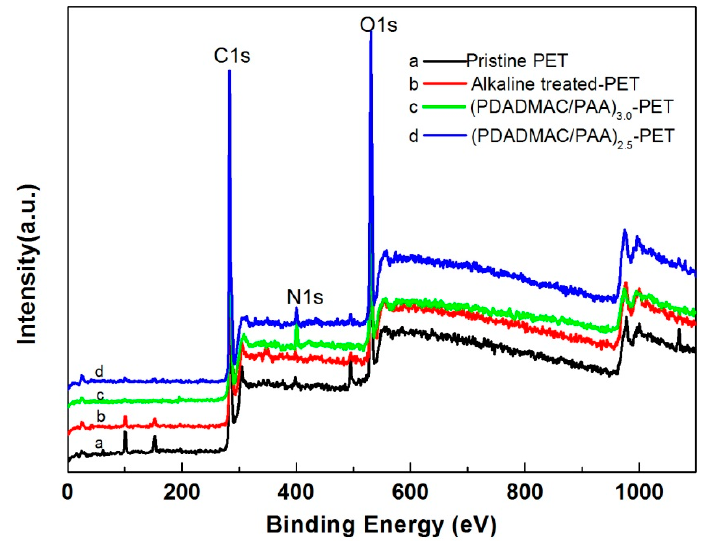
Figure 5. X-ray photoelectron spectroscopy (XPS) spectra of pristine fabric (a), alkaline treated fabric (b), (PDADMAC/PAA) 3.0 -PET fabric (c) and (PDADMAC/PAA) 2.5 -PET fabric (d). Table 1. Relative surface chemical composition of different PET fabrics.